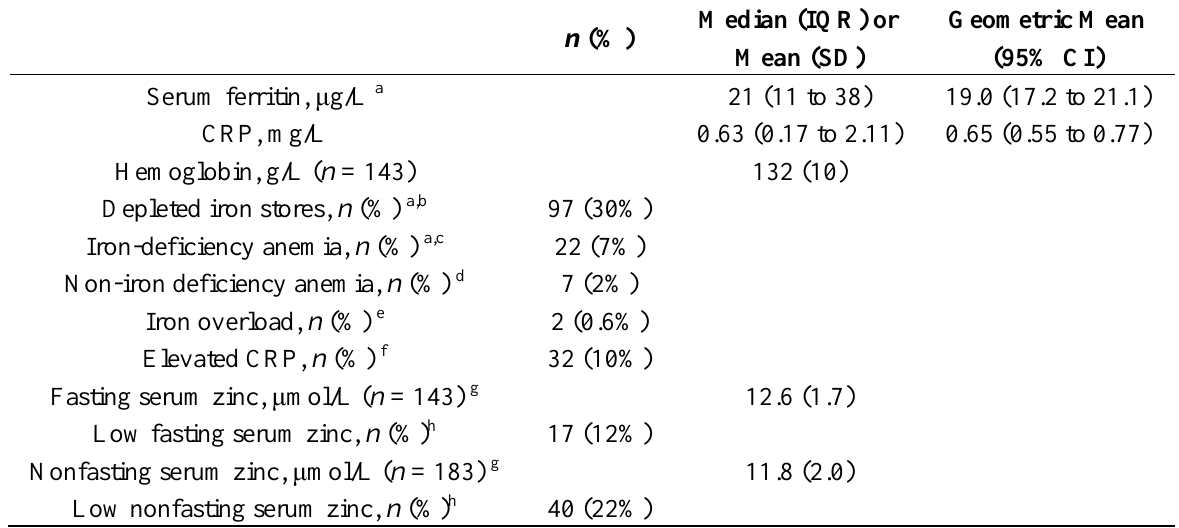
Table 5. Biochemical measures of iron and zinc status in women aged 18–50 years ( N =